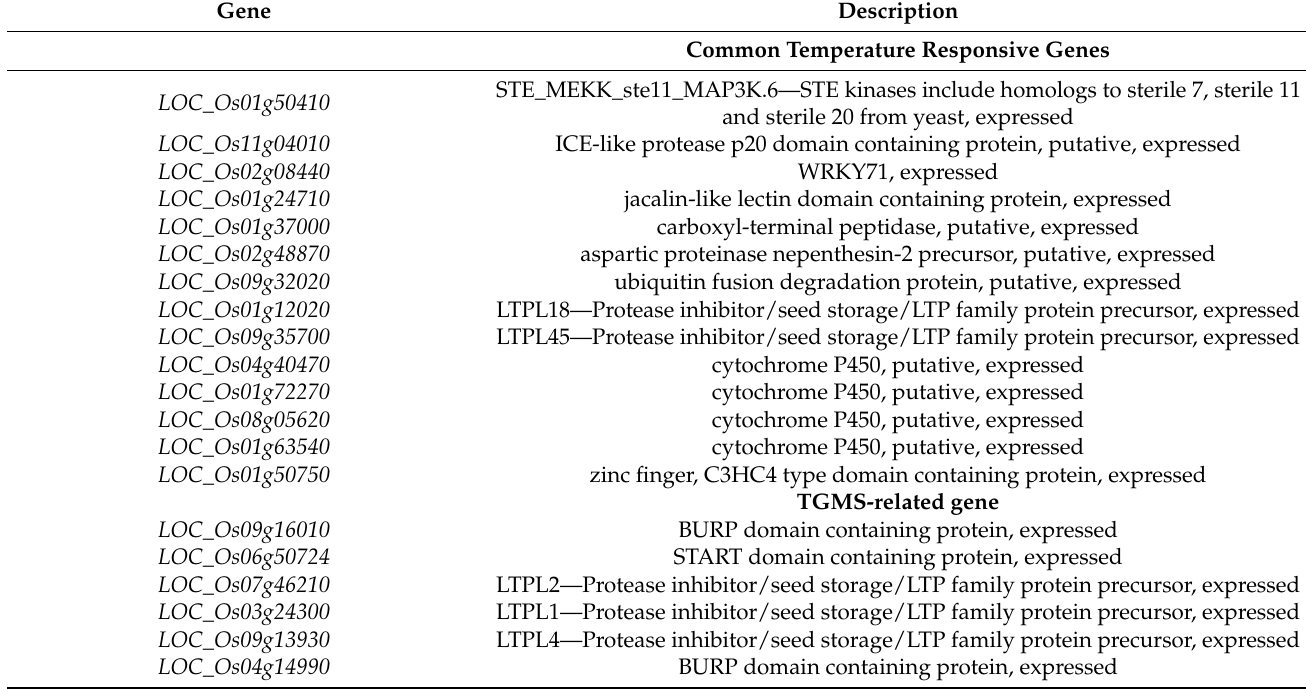
Table 4. Common temperature responsive genes and TGMS-related